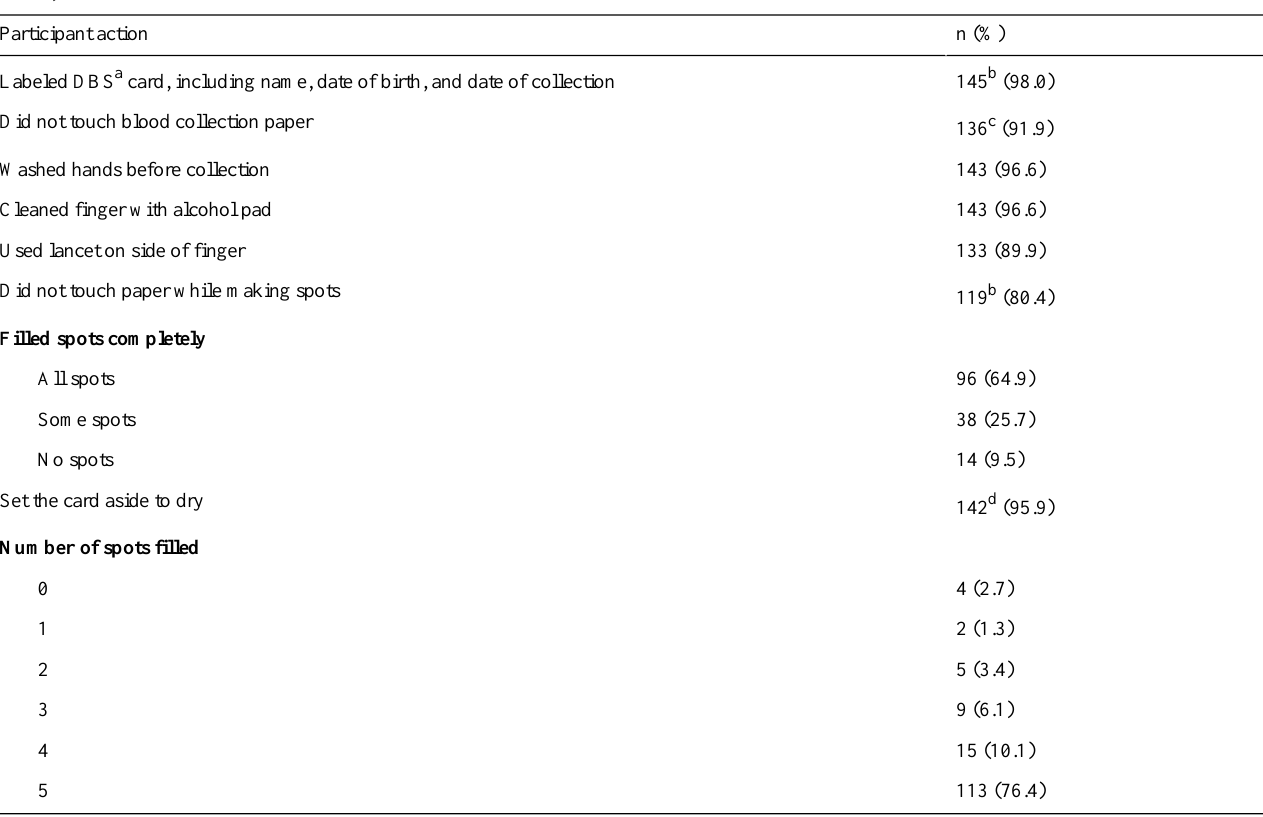
Table 4. Clinician-documented participant actions when collecting DBS samples and conducting COVID-19 self-testing during the iCollect study